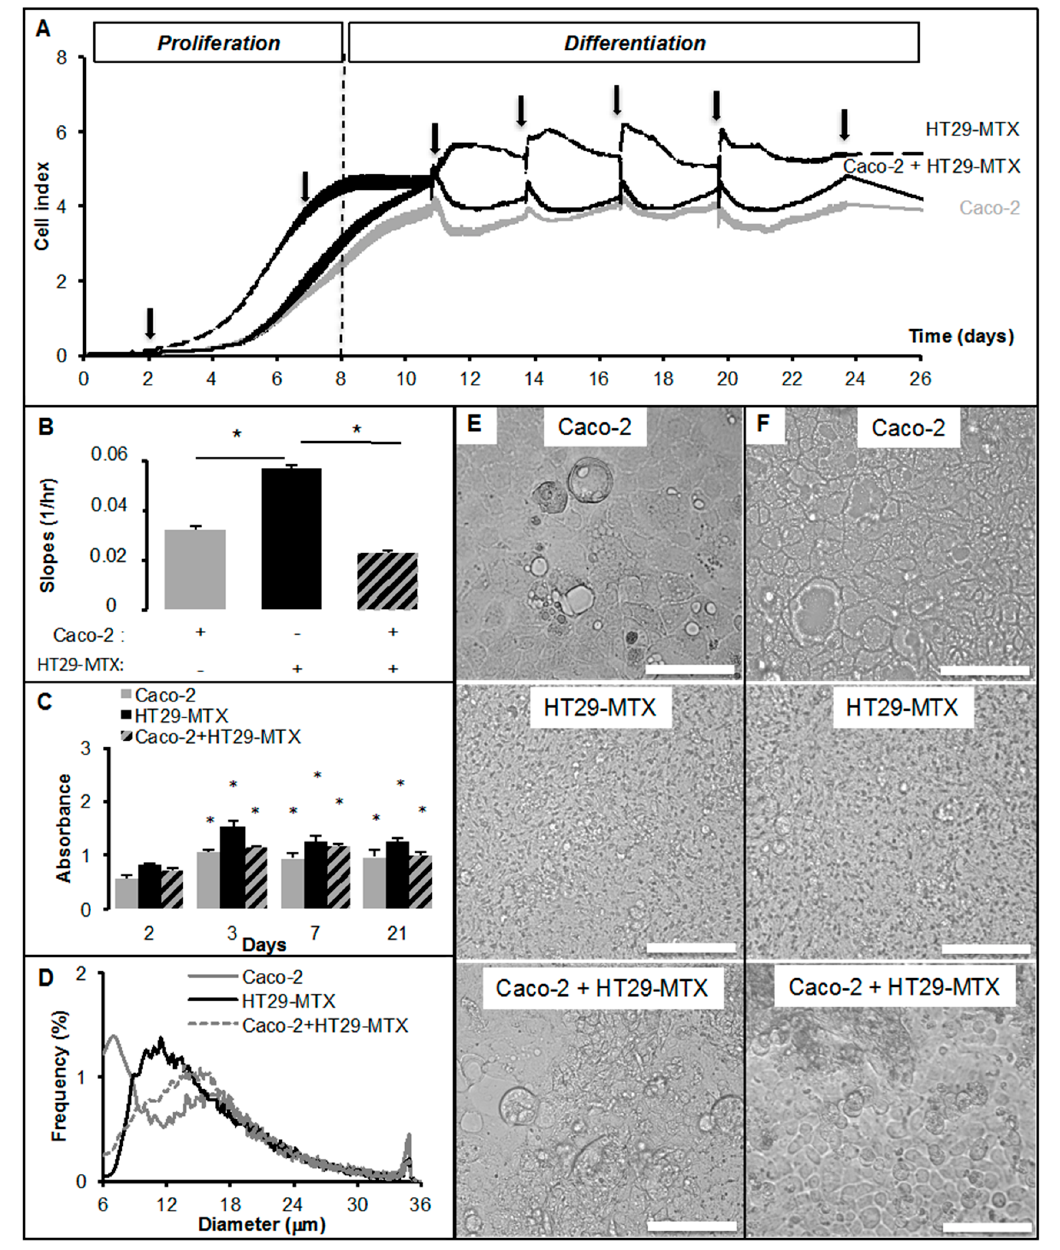
Figure 3. Real-time monitoring of proliferation and differentiation of Caco-2, HT29-MTX cells, and co-cultures (representative experiment). Cells were plated in either 96E-plates or 96 wells plates at low density (5000 cells/cm 2 , ( A , B , D , E , F ) or 75,000 cells/cm 2 ( C ) and cultured separately or mixed (Caco-2 cells: 90%; HT29-MTX cells: 10%). The cell indexes were measured on xCELLigence system ( A ) every 15 min and the media were replaced every 2–4 days (indicated by arrows) until full differentiation, i.e., 18 days after they reached confluency (Day 8); ( B ) Proliferating phase slopes were calculated from the linear phase. Data are presented as means ± SEM ( n = 8 wells); ( C ) Cell survival and/or proliferation was checked using MTT test; ( D ) Cell size distribution at Day 18 was analyzed on Scepter cell counter. Data are presented as mean ± SD ( n = 3); Micrographs taken 2 days (Day 2, E ) and 18 days (Day 18, F ) post-confluency at magnification ×20 (scale bar = 100 μ m). Asterisks represent significant Student t -test p -values < 0.05.